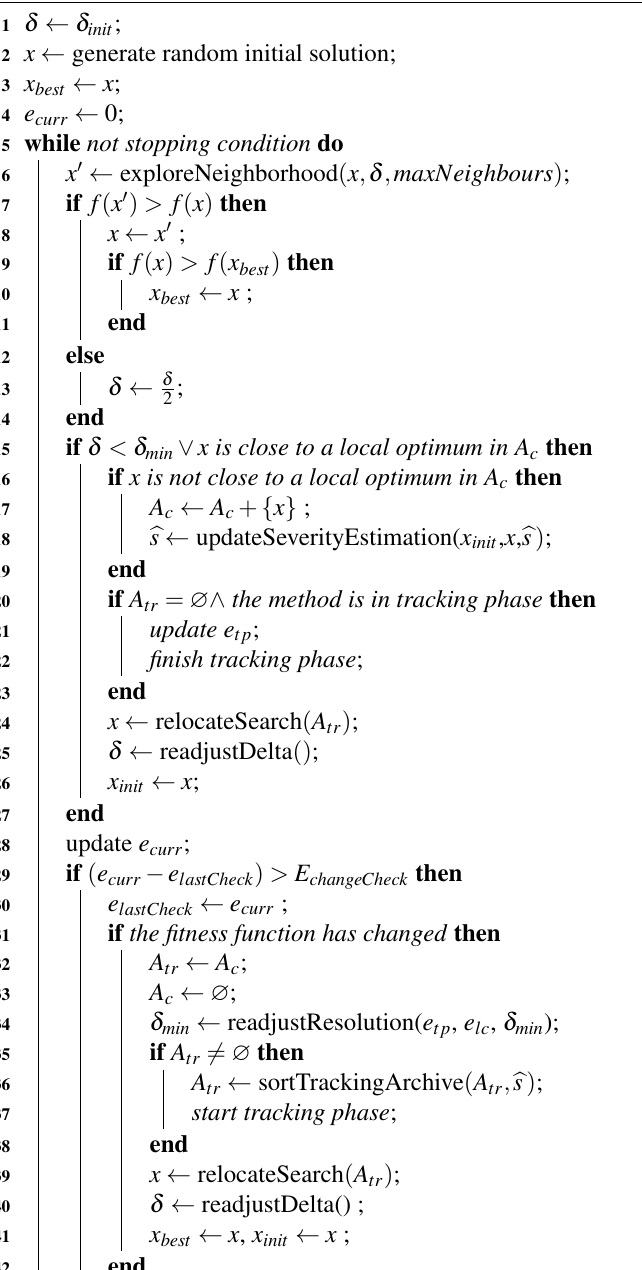
Algorithm 7: Pseudo-code for the complete working of the adaptive local